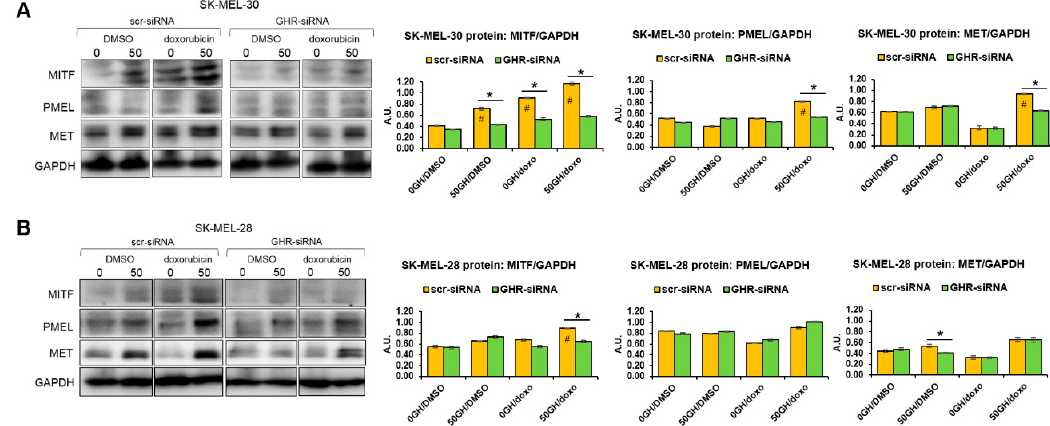
Figure 3. GH treatment directly upregulates MITF and MITF target proteins’ expression in human melanoma cells: ( A , B ) Human melanotic melanoma cells SK-MEL-30 ( A ) and SK-MEL-28 ( B ) were treated with / without 50 ng / mL recombinant human growth hormone in presence / absence of doxorubicin and siRNA-mediated GHR knockdown (GHRKD). After 48 h, protein was extracted and western-blot was performed for MITF, PMEL (PMEL17 / gp100), MET, and GAPDH followed by densitometry analysis performed using ImageJ (NIH) and expression were normalized against expression of GAPDH as loading control (#,*, p < 0.05, Students t test, n = 3; # indicates comparison against untreated (-GH, -dox, -GHRKD) control).